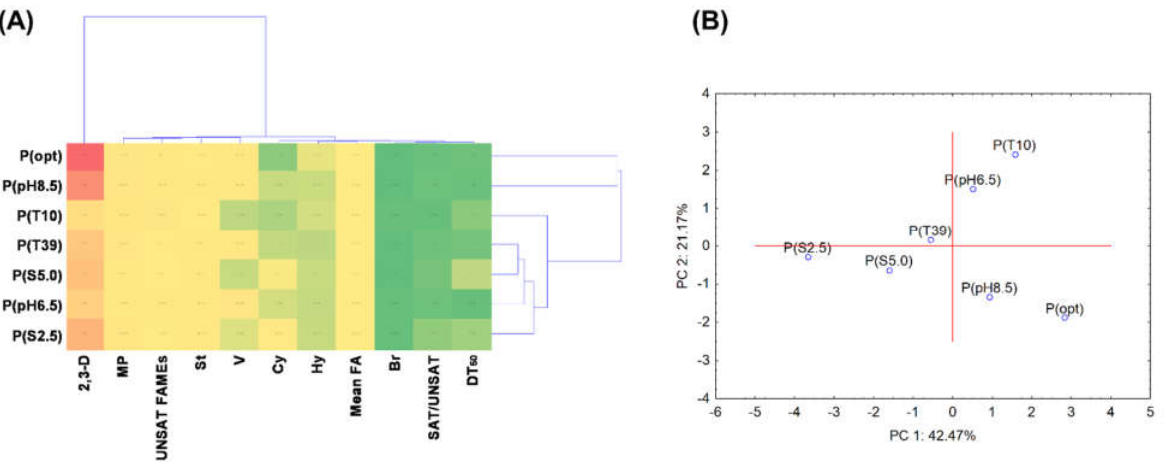
Figure 5. Projection of cluster analysis dendrograms ( A ) and PCA analysis biplots ( B ) for S. maltophilia KB2 under different culture conditions. Table 5. Pearson's correlation matrix for phenol degradation kinetic parameters, catechol 2,3-diox- ygenase activity, membrane permeability, and FAME indexes for S. maltophilia KB2 under subopti- mal growth conditions.